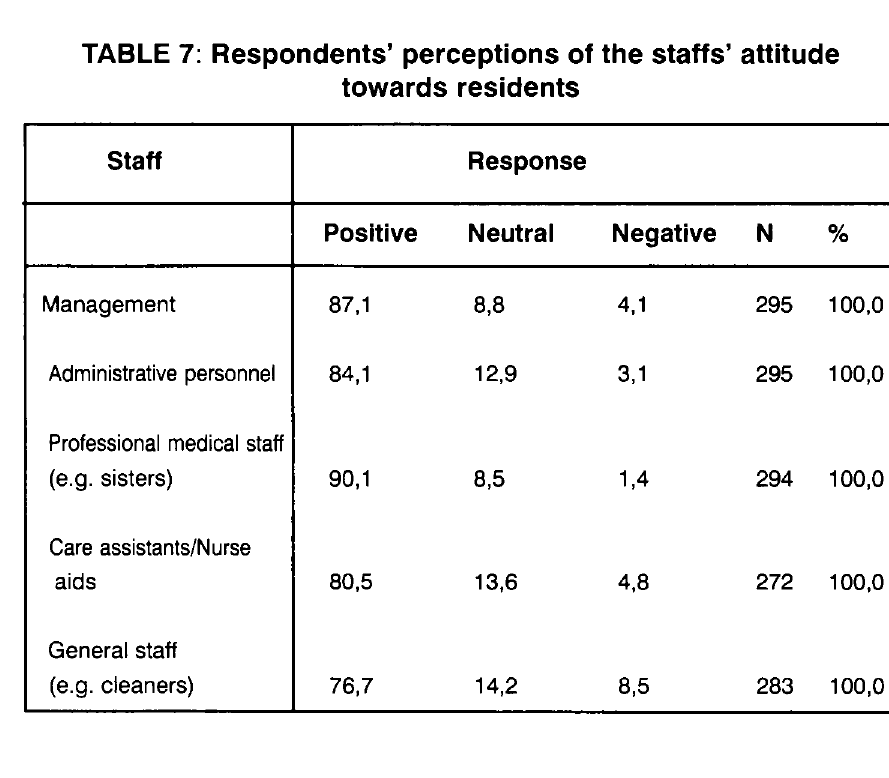
TABLE 8*: Respondents’ perceptions of the attitude of the public in general towards the